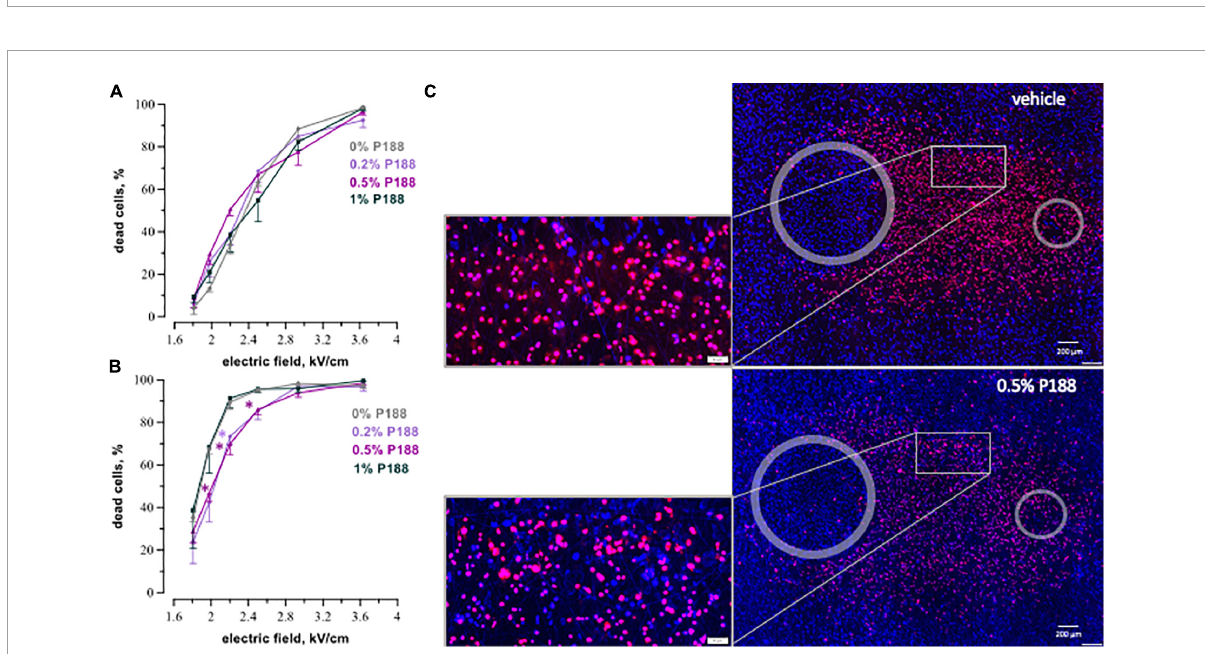
FIGURE6 P188 protects cardiac cells against microsecond electric pulses. The plots display the percent of dead cells at 8 h (A) and 24 h (B) after exposure to 20, 100- µ sPEF shocks at 1 Hz. P188 was added at indicated concentrations (0% is vehicle control) 10 s after the end of µ sPEF exposure. Mean ± SEM, 3 experiments for each P188 concentration. * p < 0.05 for the difference between vehicle and P188 at the same electric field strength. The protective effect became significant at 24 h for P188 at 0.5% at the electric field strengths from 2.0 to 2.5 kV/cm and at 0.2% at 2.2 kV/cm. Panel (C) displays the example fluorescence images of cell monolayers at 24 h after exposure to µ sPEF